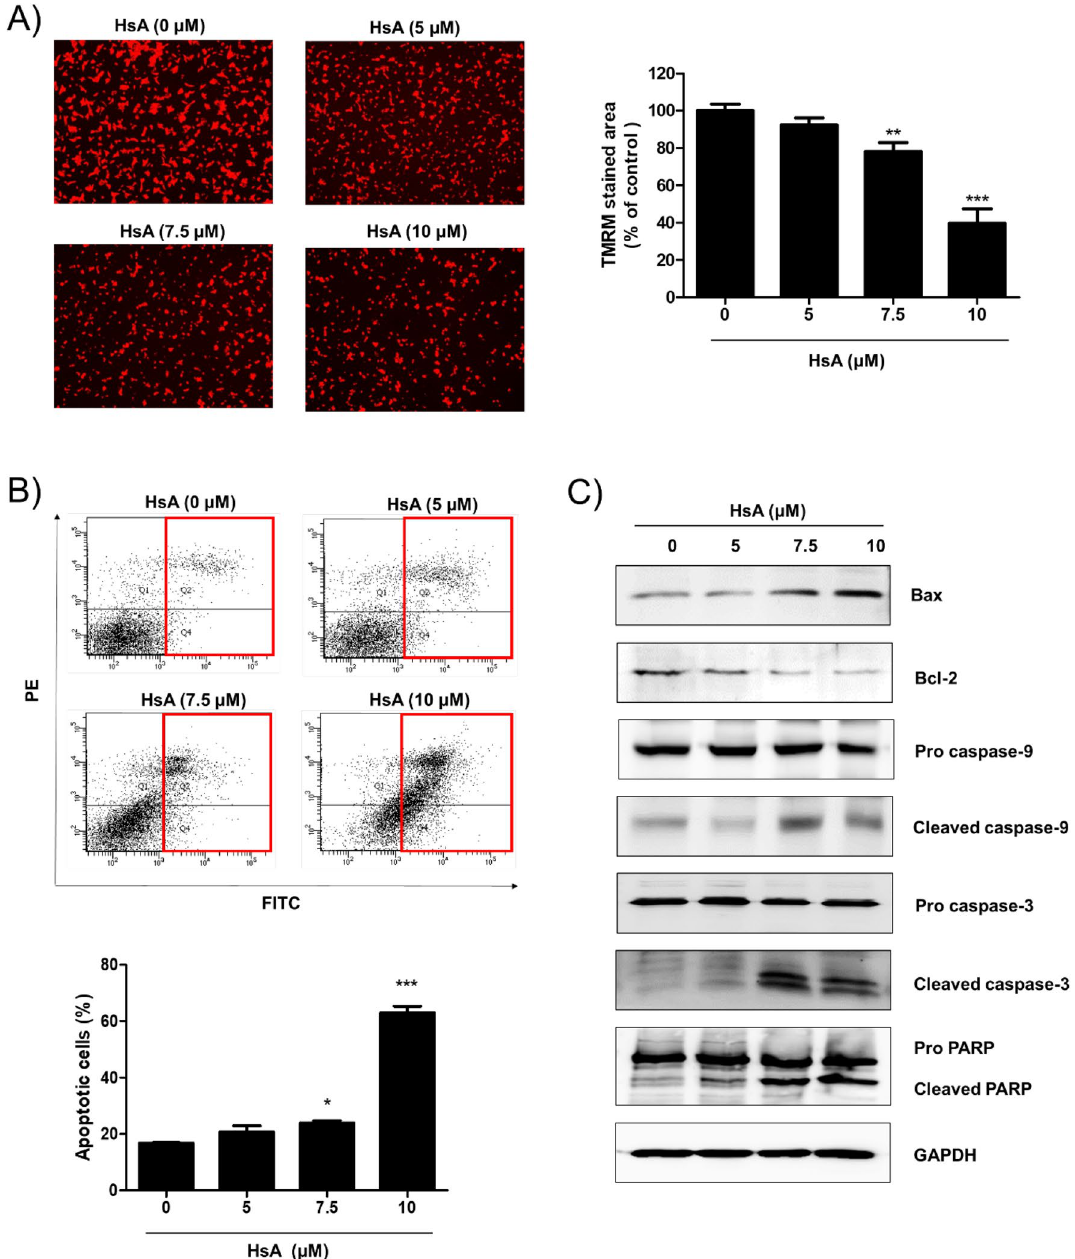
fluorescent was measured and indicated as a percentage of control. ( B ) DLD-1 cells were treated with HsA (0, 5, 7.5, 10 μM) for 24 h. The cells were stained with Annexin V and PI, and the number of apoptotic cells was measured by FACS. ( C ) DLD-1 cells were treated with indicated concentrations of HsA (0, 5, 7.5, 10 μM) for 24 h. The protein levels of Bax, Bcl-2, caspase-3, caspase-9, and PARP were examined by Western blot analysis. GAPDH expression was used as an internal loading control. The results ( A , B ) are shown as mean ± SEM. *p < 0.05; **p < 0.01; ***p < 0.001 compared with the control